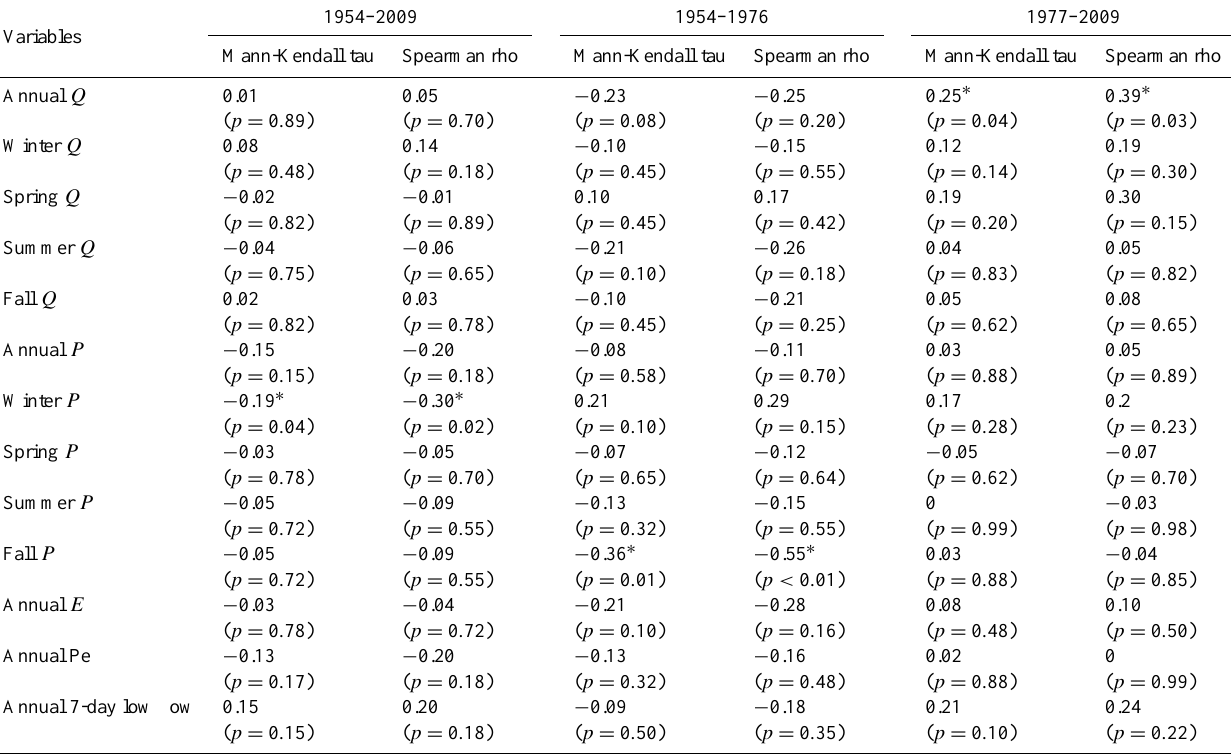
Table 1. Trends in hydrological and climatic variables from 1964 to 2009.